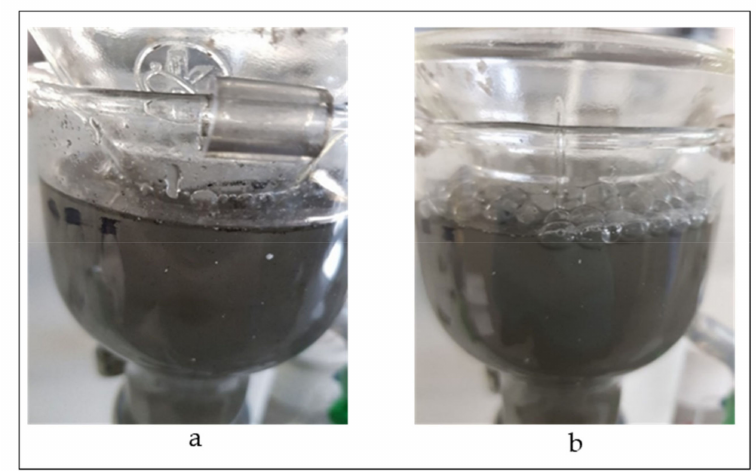
Figure 7. ( a ) Absence of frothing in the presence of a 50% pseudo-monolayer SEX coverage and 4 × 10 8 cells / mL of microbes. ( b ) Frothing e ff ect observed in the presence of 4 × 10 8 cells / mL of microbes without